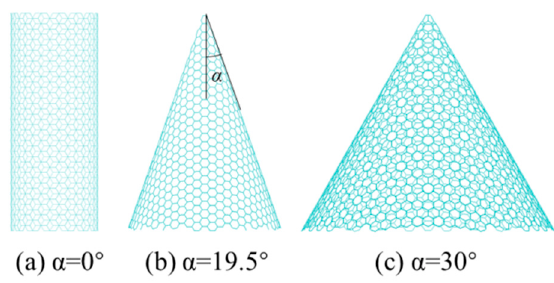
Figure 1. CNC configurations for different cone angles.